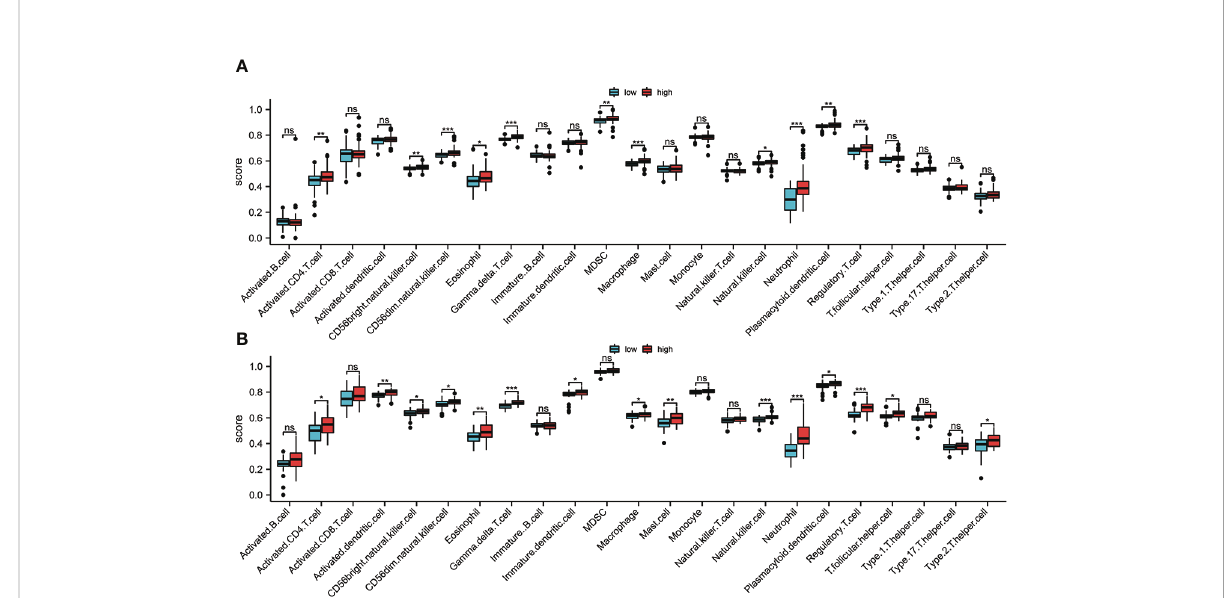
FIGURE 7 Immune in fi ltration analysis. (A) In the discovery set, the immune cell in fi ltration between groups with high and low risk was evaluated based on the ssGSEA algorithm. (B) In the validation set, the immune cell in fi ltration between high-risk and low-risk groups was analyzed based on the